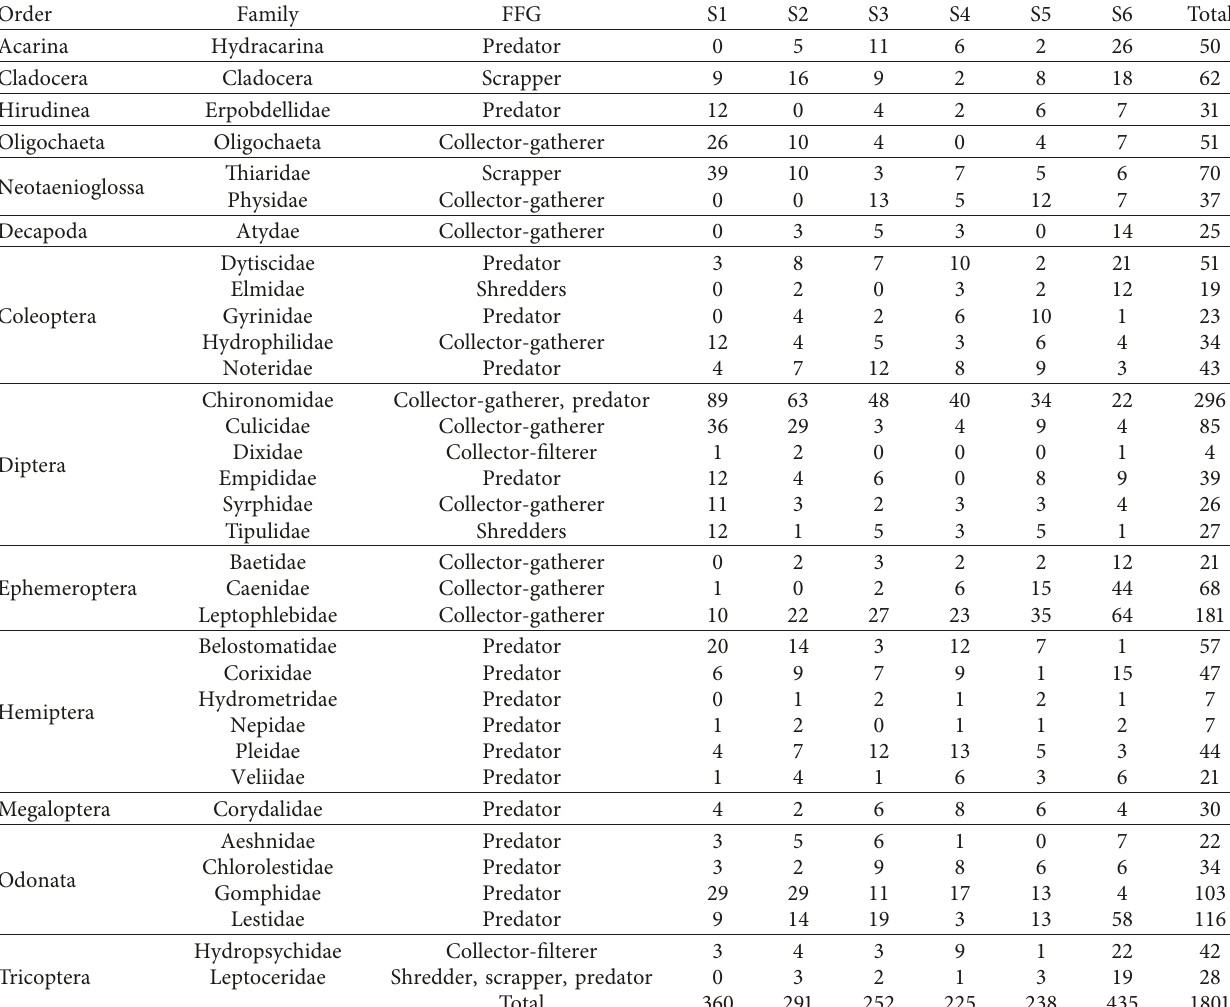
Table 3: List of observed macroinvertebrates between January and March 2018 in Sanyati basin, Lake Kariba. Order